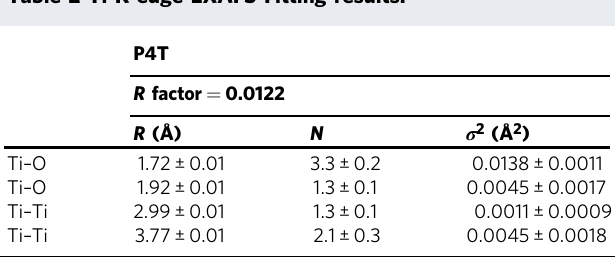
Fig. 3 EXAFS and XPS analysis of the synthesized photocatalysts. EXAFS spectra a Ru K edge, b Ti K edge, fi tting edges of c , d P4T cluster, XPS spectra of P4T, e Survey, f Ti 2 p , g Ru 3 d , h O 1 s , and i N 1 s . Table 2 Ti K edge EXAFS Fitting